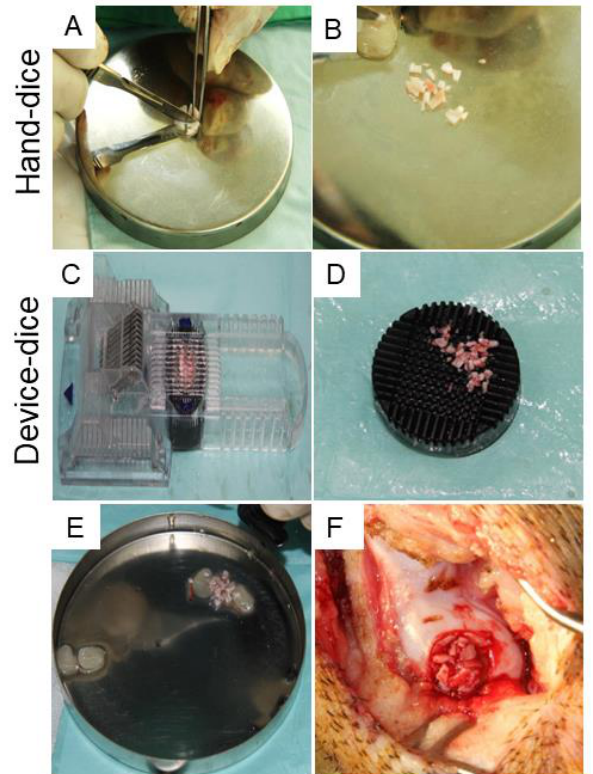
Figure 7. A full-thickness articular cartilage defect was created at the medial femoral condyle, then the harvested graft was processed into cartilage grafts using either the hand-diced method ( A and B ) or a device-diced method that employs a custom-made cartilage grinder ( C and D ). ( E and F ) After mixing with PRF, the diced cartilage grafts were implanted into the defects.